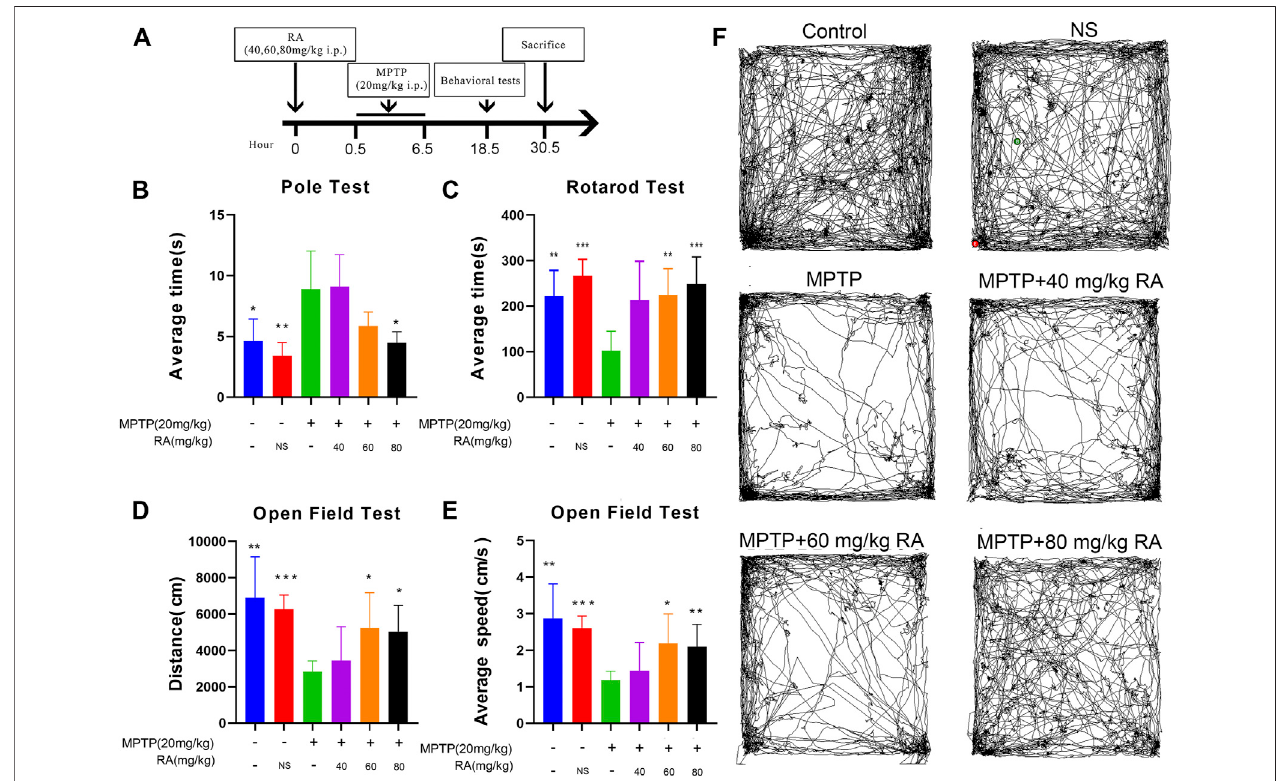
FIGURE 1 | RA pre-administration ameliorated MPTP-induced motor abnormalities in MPTP mice. The experimental schedule for RA intervention in the MPTP- micemodelisshownin (A) .Thepoletest (B) ,rotarodtest (C) ,andopen- fi eldtest (D,E) wereusedtoevaluatethemotorfunctionofPDmice.Representativeexamplesof movementpath (F) wereselected.ComparedwiththecontrolandPBS,theMPTP-injectedmiceshowedahigherclimbingtimeinthepoletest,decreasedlatencyinthe rotarod test, and decreased movement distance and speed in the open fi eld test. RA shortened the pole test ’ s climbing time, increased the rotarod test ’ s latency, andincreasedmovementdistanceandspeedintheopen fi eldtest.Dataareexpressedasmean±SD.One-wayanalysisofANOVAwithDunnett ’ sT3testwasused.N= 10 mice per group, * p < 0.05, ** p < 0.01, *** p < 0.001 when compared with the MPTP